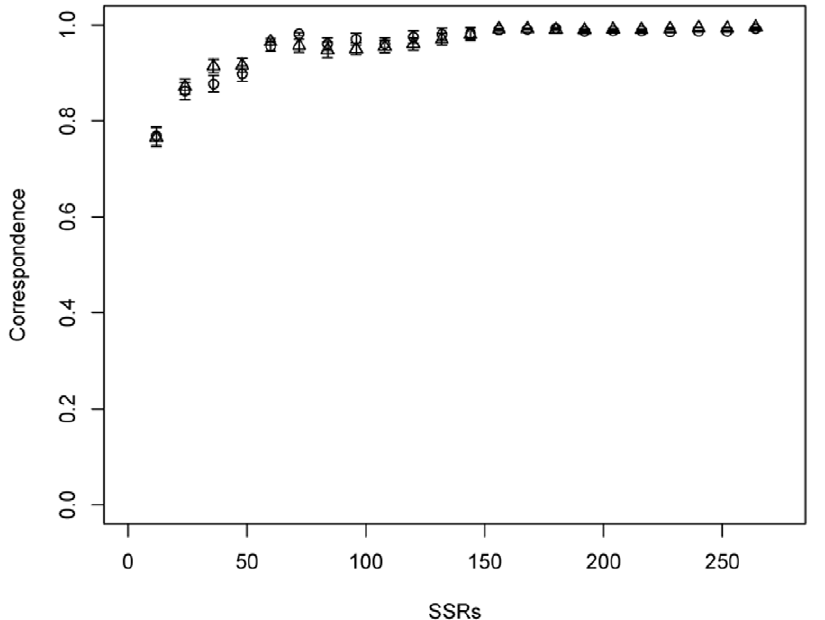
Figure 5. Correspondence between the assignment of all 150 rice varieties by MCLUST based on the entire set of 274 SSRs and on different subsets of SSR markers (from 12 to 274 with grads of 12) selected ( a ) at random (triangles) or stratified (circles) with 100 replications. The vertical lines at each point indicate the standard error. For details see Materials and Methods.